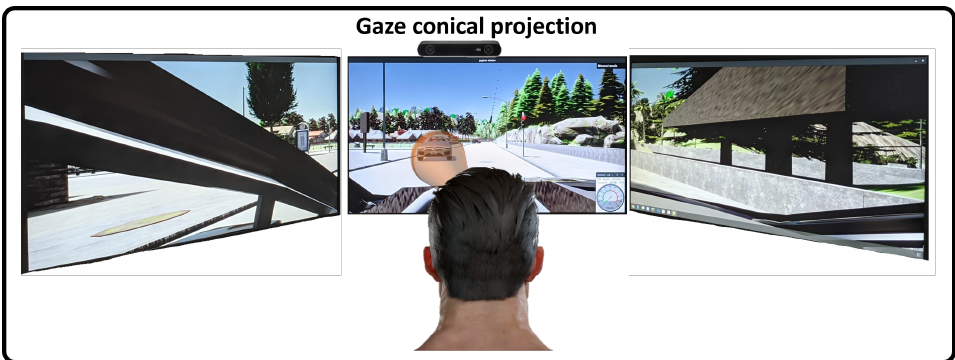
Figure 5. Circular uncertainty gaze area with a radius of 30 pixels on the image following a conical projection represented with an orange